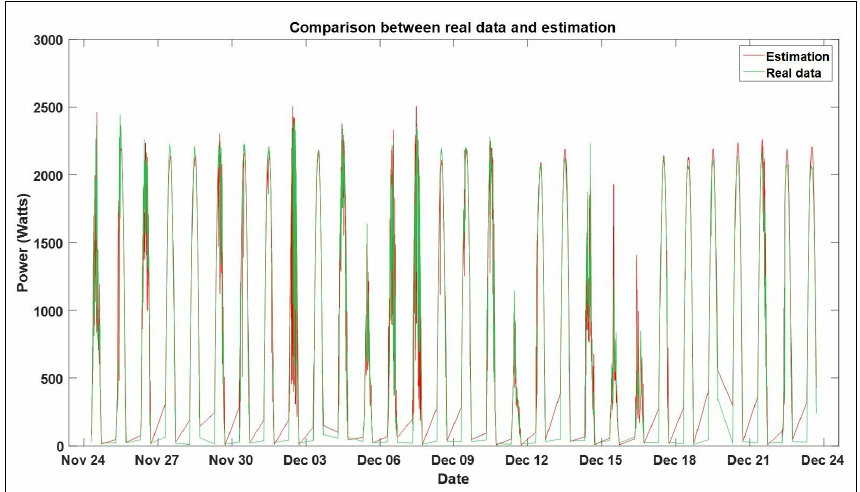
Figure 9. A close-up of the results from